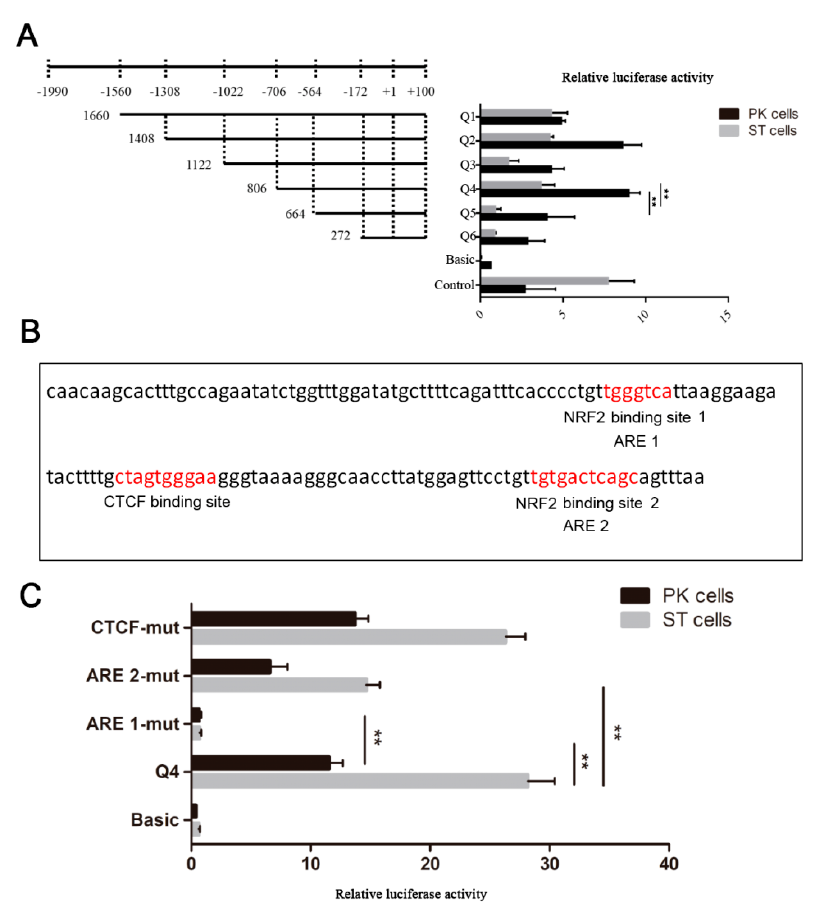
Figure 3. Identification of AKR1C1 gene promoter region. ( A ) Luciferase activity assay of AKR1C1